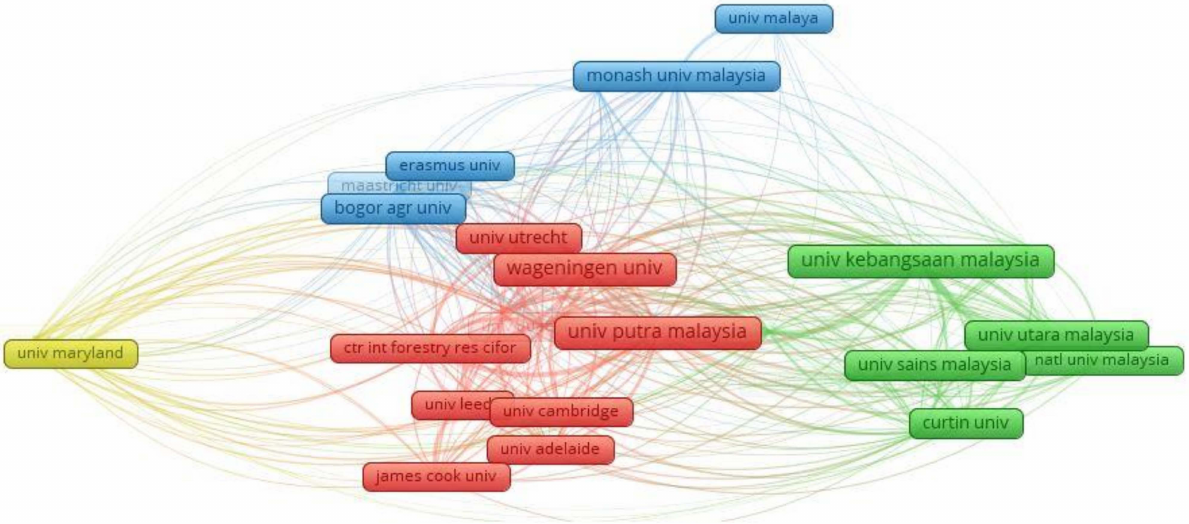
Figure 8. Bibliometric coupling